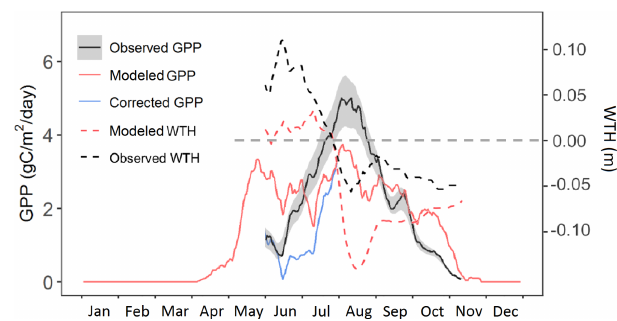
Figure 3. Predicted GPP (solid red line) compared with flux- partitioned GPP (solid black line; GPP data were not used in the parameters optimization) of Sphagnum mosses for the year 2014. The blue line is the predicted GPP corrected with the observed wa- ter table height. The dashed black and red lines are observed and modeled water table height (the dashed gray line is the hollow sur-